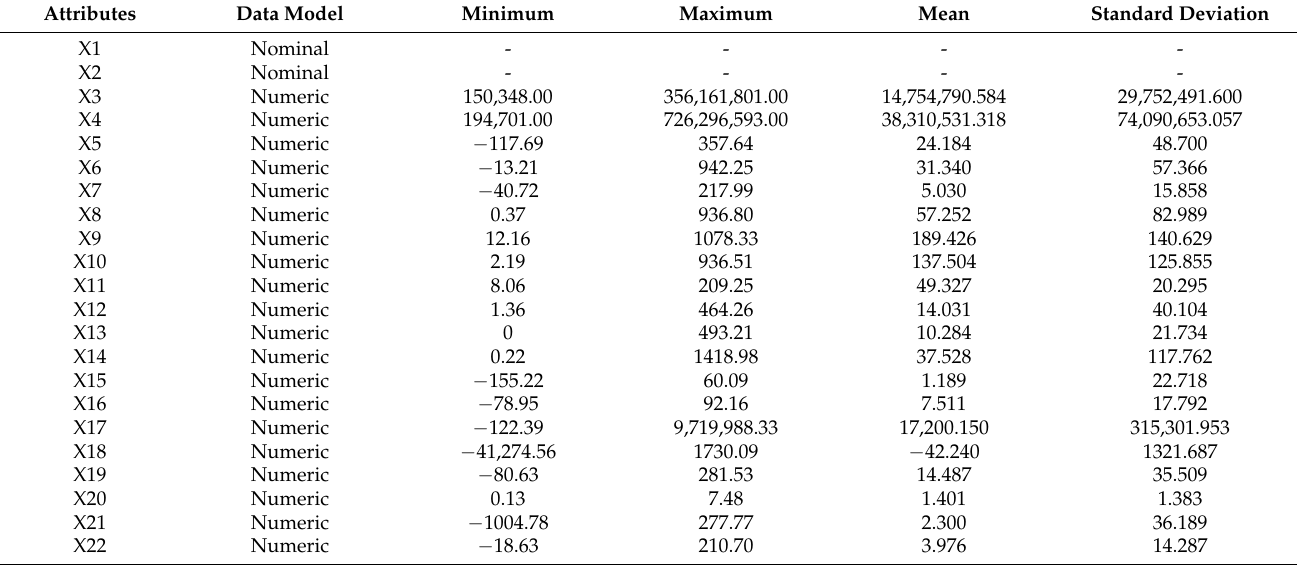
Table 4. Information of descriptive statistics for the 491 normal and 491 bankrupt